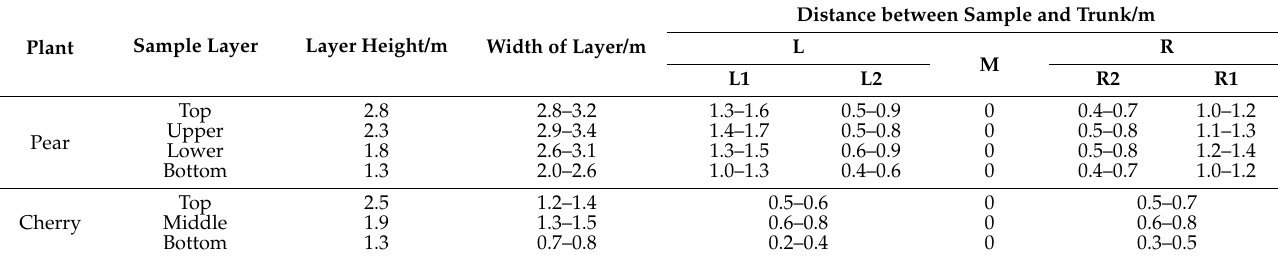
Table 1. Layers and samples setting parameters of pear and cherry.